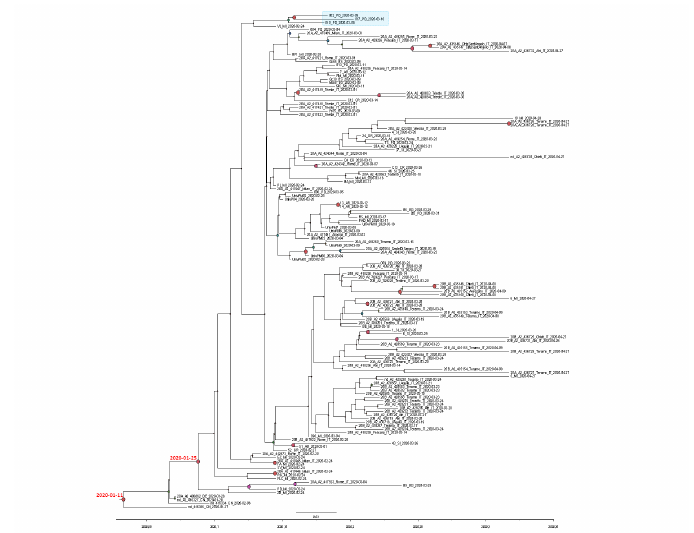
Figure 2. SARS-CoV-2 tree of 136 Italian strains plus one German and three Chinese isolates from Shanghai, showing statistically-significant support for clades along the branches (posterior probability > 0.7). Large red and purple circles indicated highest posterior probability ranging from 1 to 0.9. Calendar dates of the tree root and the Italian clade were showed in red. The light blue box highlighted the three Padua isolates carrying G1046V mutation in S